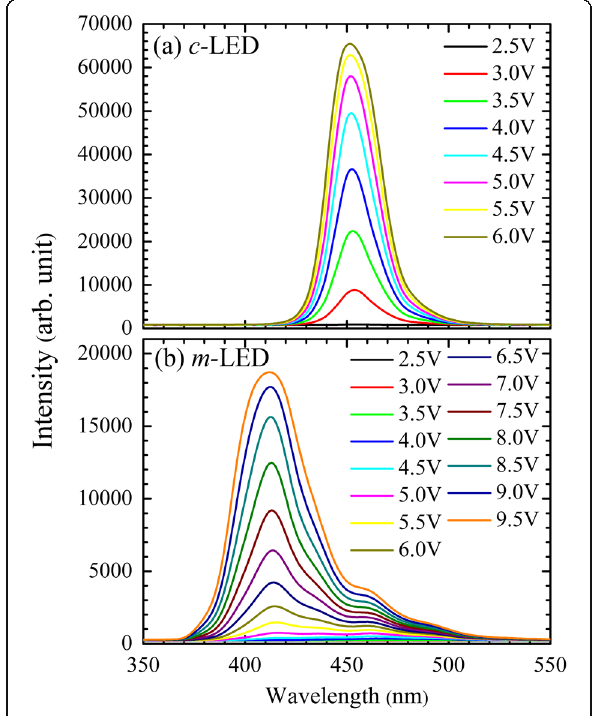
Fig. 1 EL spectra for the ( a ) c - and ( b ) m